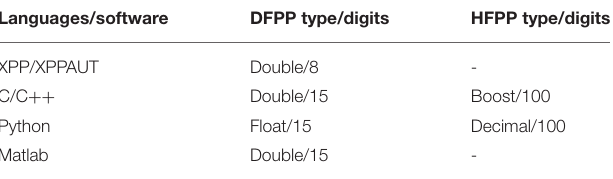
TABLE 3 | Floating-point precision (FPP) digits and types used in each